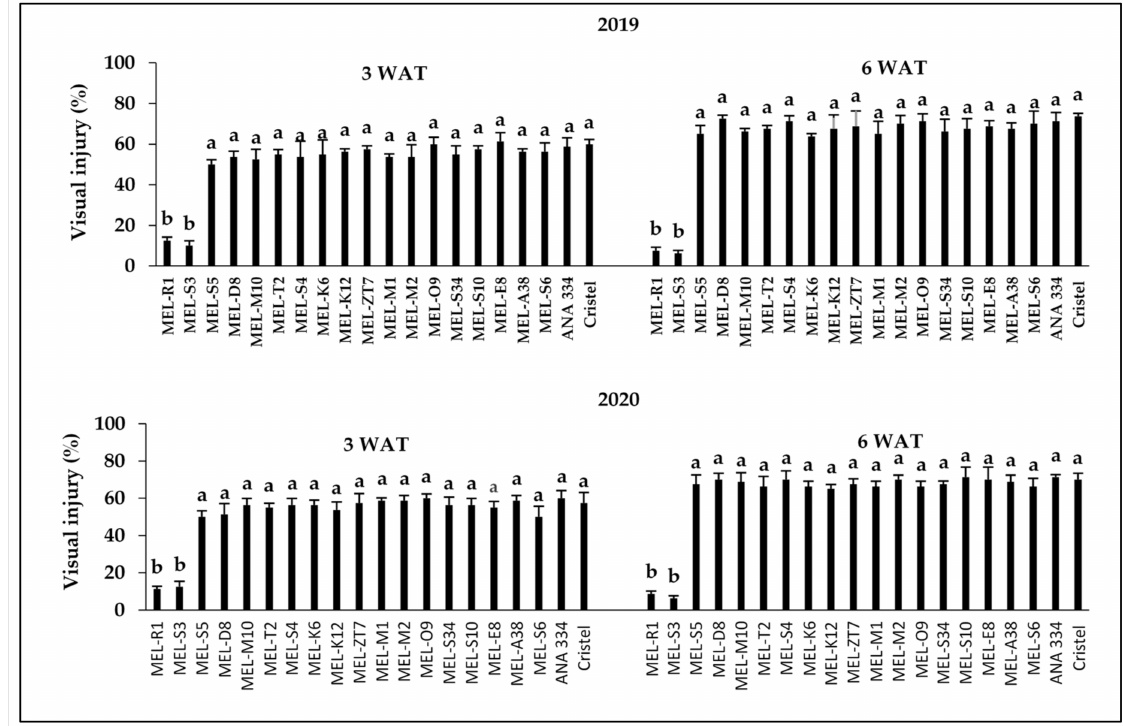
Figure 2. Response of melon accessions and commercial cultivars to 2,4-D application at the rate of 11.2 g ae ha − 1 3 and 6 weeks after treatment during 2019 and 2020. Means in each chart followed by different letters are significantly different at p ≤ 0.05 using LSD